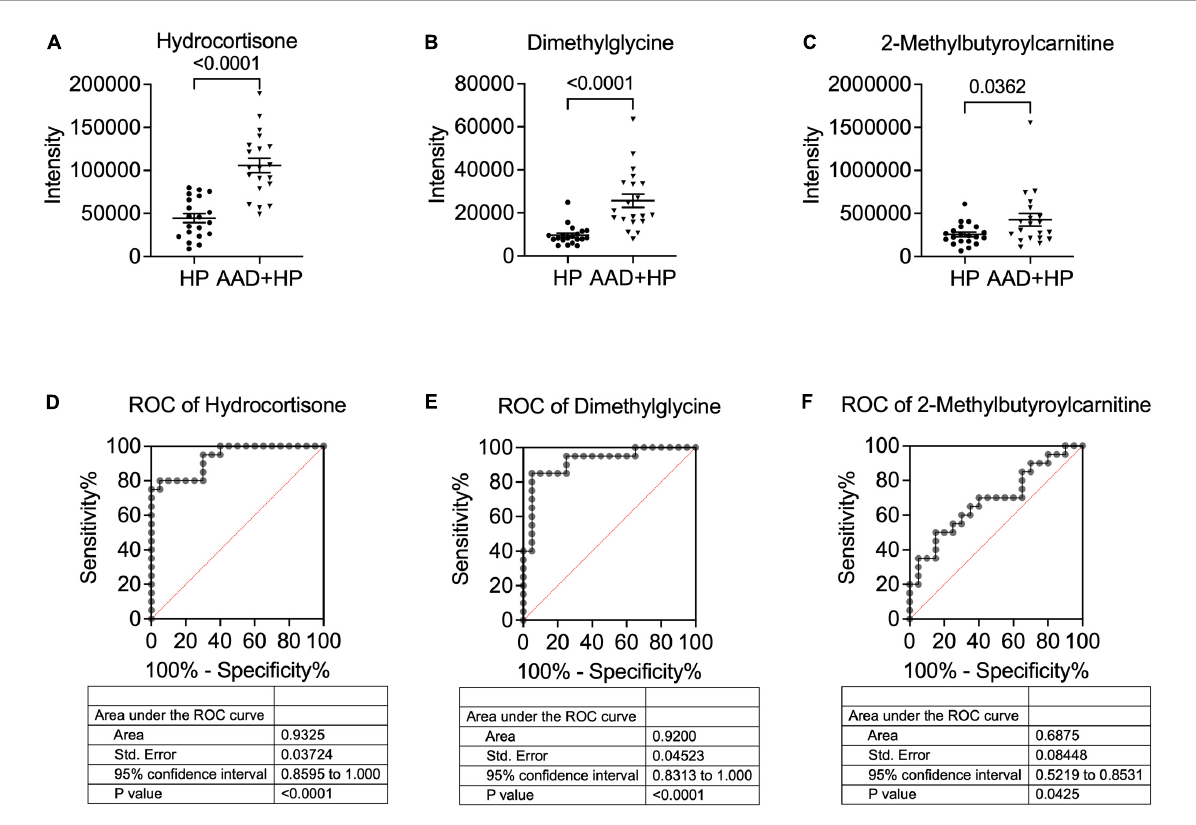
FIGURE4 Concentration and ROC analysis of candidate metabolites in the two groups. Comparison of hydrocortisone blood levels. (A) dimethylglycine (B) and 2-methylbutyroylcarnitine (C) in patients with hypertension and AAD + hypertension. The ROC analysis showed that hydrocortisone (D) exhibited the highest AUC value, followed by dimethylglycine (E) and 2-Methylbutyroylcarnitine (F) . AUC, Area under the curve; ROC, receiver operating